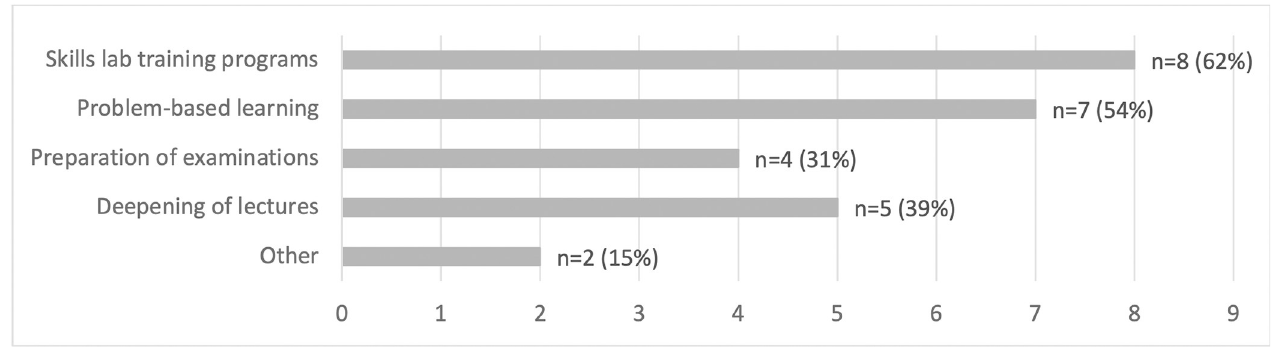
Fig 4. Fields of application of interprofessional PAL at institutions [multiple answer options, sample n = 12].